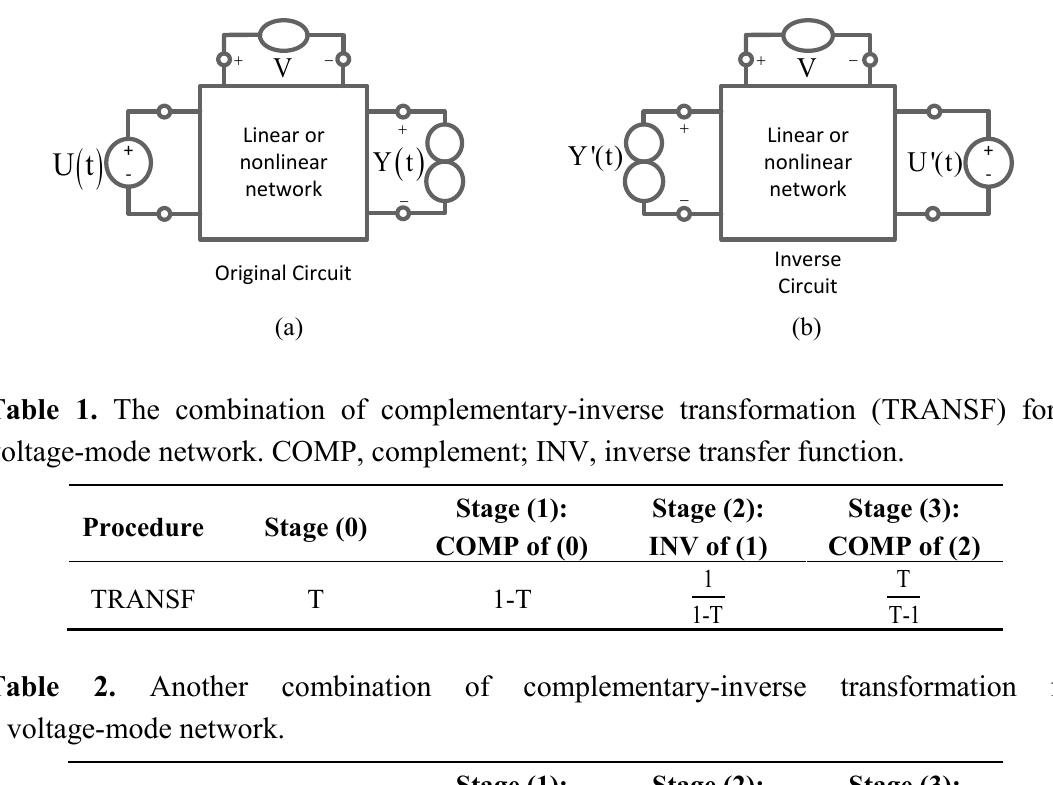
Figure 2. The inverse transformation of a circuit. ( a ) Original network; ( b ) inverse network of ( a ).